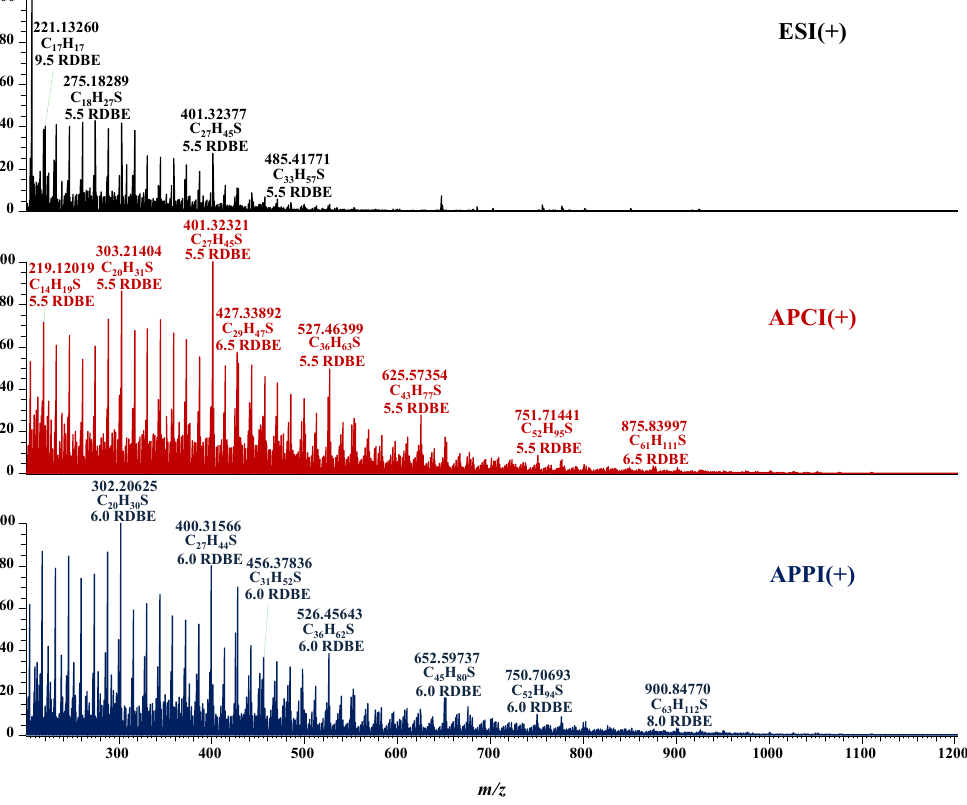
Figure 4. Spectra of saturates from Arabic medium oil in the mass range of m/z 200–1200, using different ionization techniques: ESI(+) (top), APCI(+) (middle) and APPI(+) (bottom).